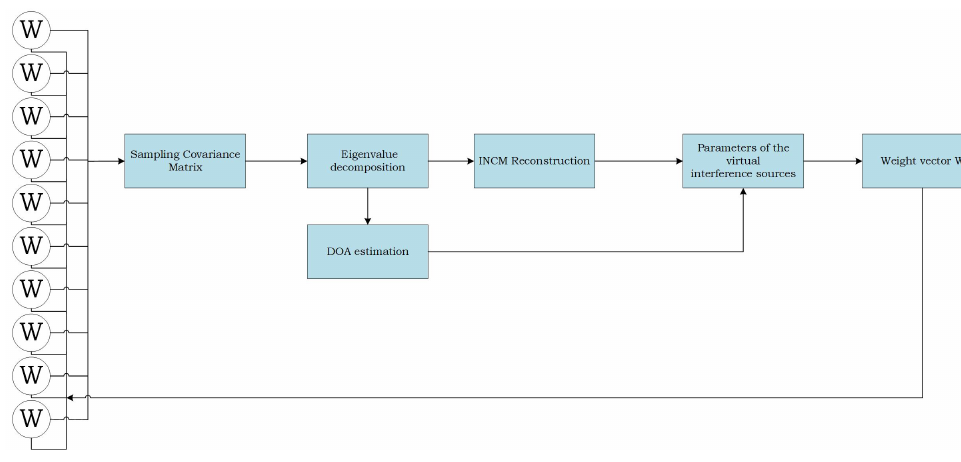
Figure 2. Flow of the proposed beamformer algorithm. Table 2. Comparison of computational